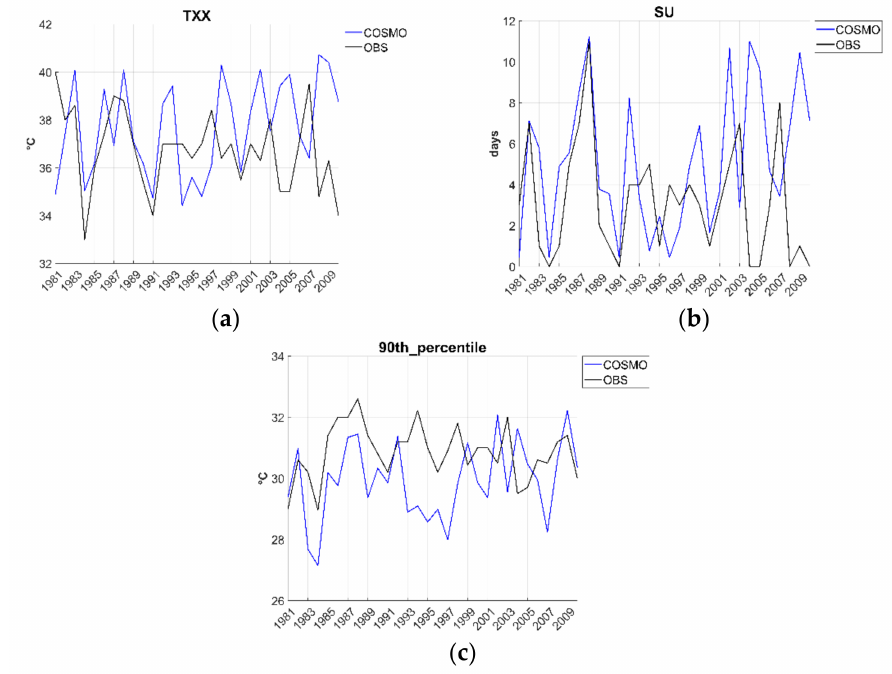
Figure 3. Time series of ( a ) TXx, ( b ) SU, and ( c ) 90p-Tmax for the model output and observational data over the historical period 1981–2010.